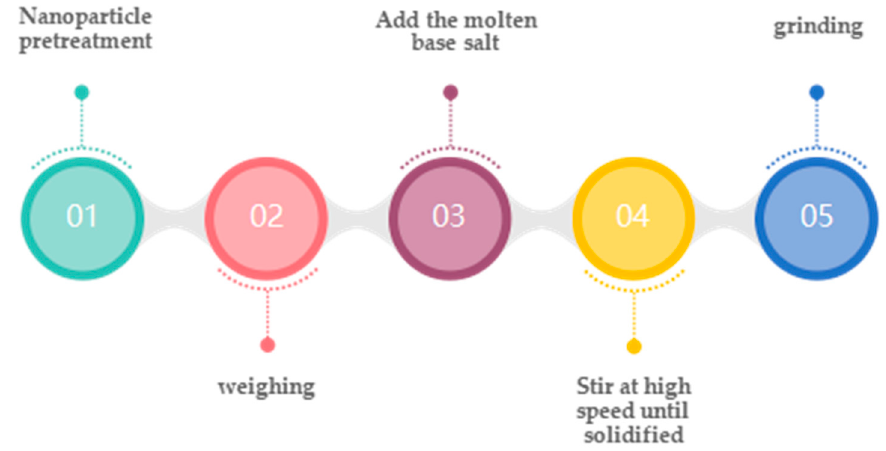
Figure 4. High-temperature melting preparation of molten salt nanofluidic flow [57].